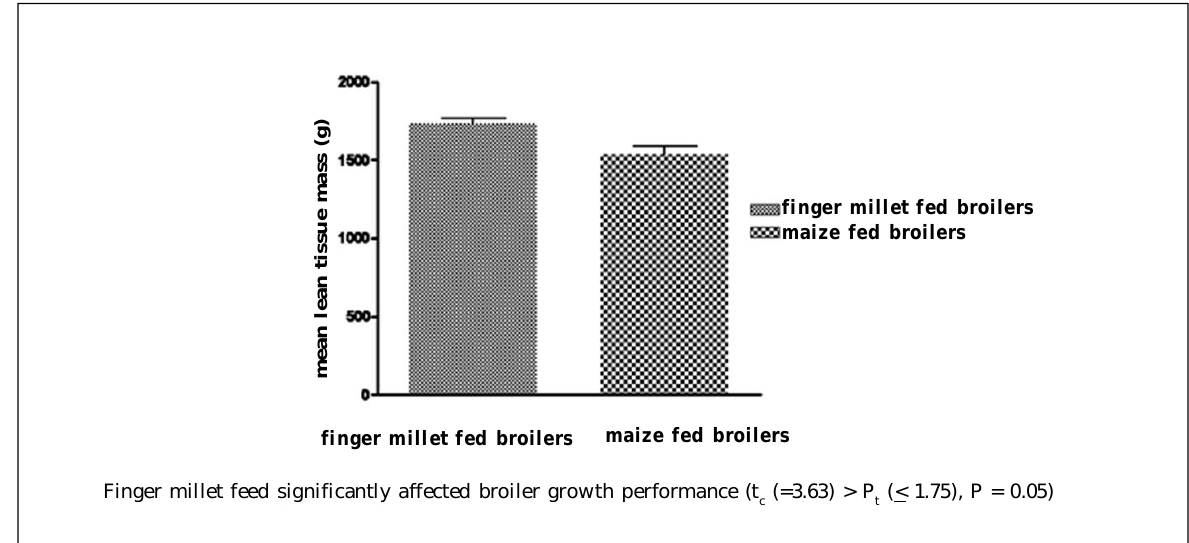
Figure 5: Mass of lean tissue of broilers fed on finger millet and maize feeds at 49 days